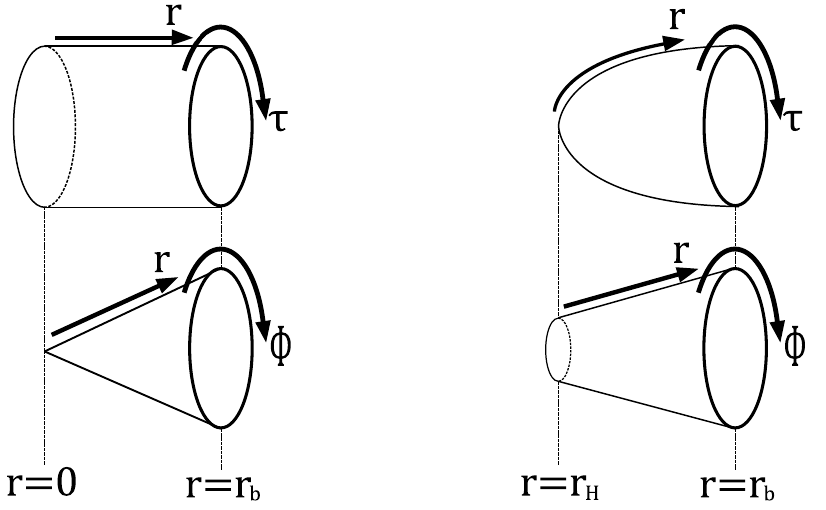
Figure 1 . ( Left ) Saddle point geometry of B 3 × S 1 topology. The upper is the r - τ section and the lower is the r - φ section. Note that the r - φ (- θ ) section is just a disc D , that is, 2(3)-ball B 2(3) , and is not conic as the figure shows, and especially there is no singularity at the center r = 0 . ( Right ) Saddle point geometry of S 2 × D topology (Euclidean BH). The r - τ section is smoothly capped at r = r . H